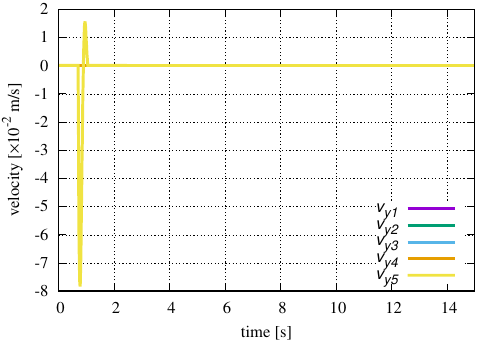
Figure 37. Case 3: Time variation of the velocities in the axial direction.